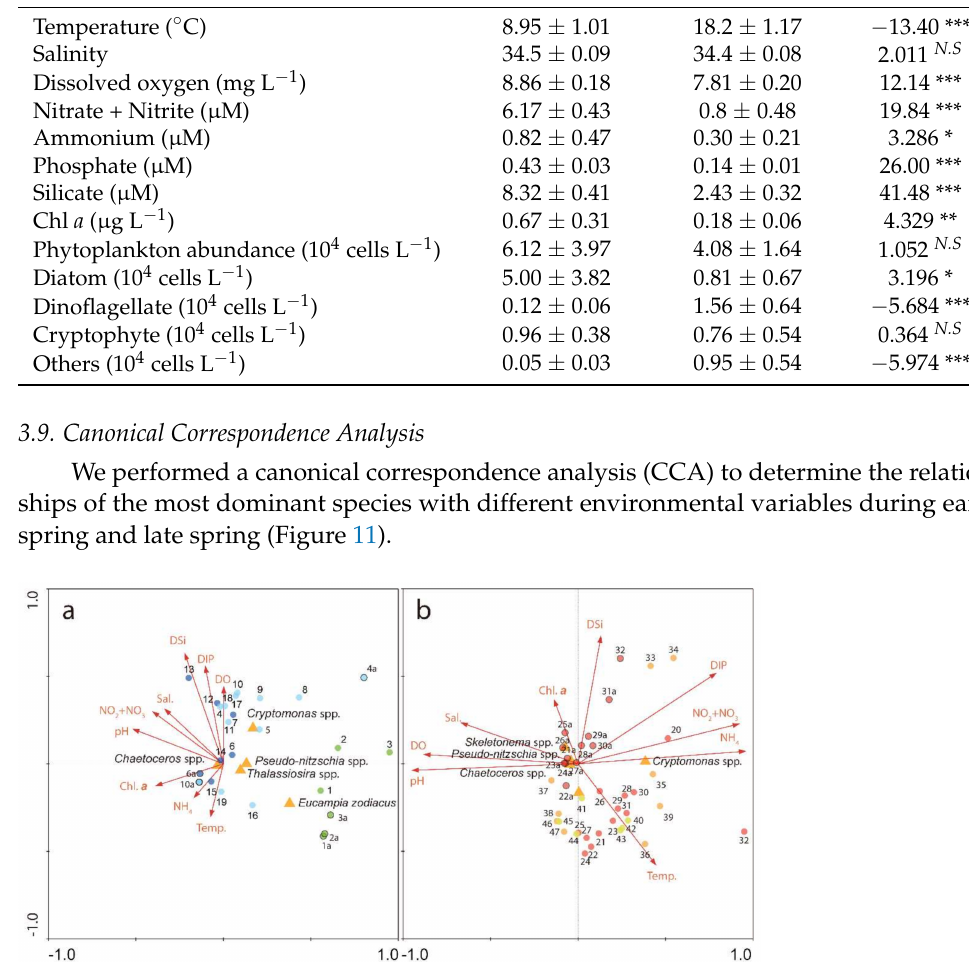
Figure 11. Canonical correspondence analysis of the relationships of the dominant phytoplankton species (circles) and sample stations (triangles) with environmental factors (arrows; temp: water temperature, sal: salinity, DO: dissolved oxygen, pH, Chl a : chlorophyll a , NO 2 + NO 3 : nitrate + nitrite, DSi: dissolved inorganic silicate, DIP: dissolved inorganic phosphate, NH 4 : ammonium) during early spring ( a ) and late spring ( b ) in the East Sea. Dots are color-coded according to zone ( a , green: CS, light blue: OS, dark blue: IS; b , red: UU, orange: UL, yellow: UD). A black outline on a colored dot indicates conditions prior to the time lag, and a black dot with the station number followed by “a” (e.g., 1a, 2a, etc.) indicates the conditions of that station after the time lag. The CCA results indicated that variables such as temperature, dissolved oxygen (DO), ammonium (NH 4 ), nitrate + nitrite (NO 2 + NO 3 ), salinity, pH, Chl a , dissolved silicate (DSi), and dissolved inorganic phosphate (DIP) can explain the variability of phytoplankton species. In particular, during early spring, Eucampia zodiacus and Pseudo-nitzschia spp. had negative correlations with nitrate + nitrite, DIP, and Dsi (all p < 0.05). Each dominant phytoplankton species had a significant correlation with Chl a (all p < 0.05), and Chaetoceros spp. had the strongest relationship with Chl a ( p < 0.01) (Figure 11a). During late